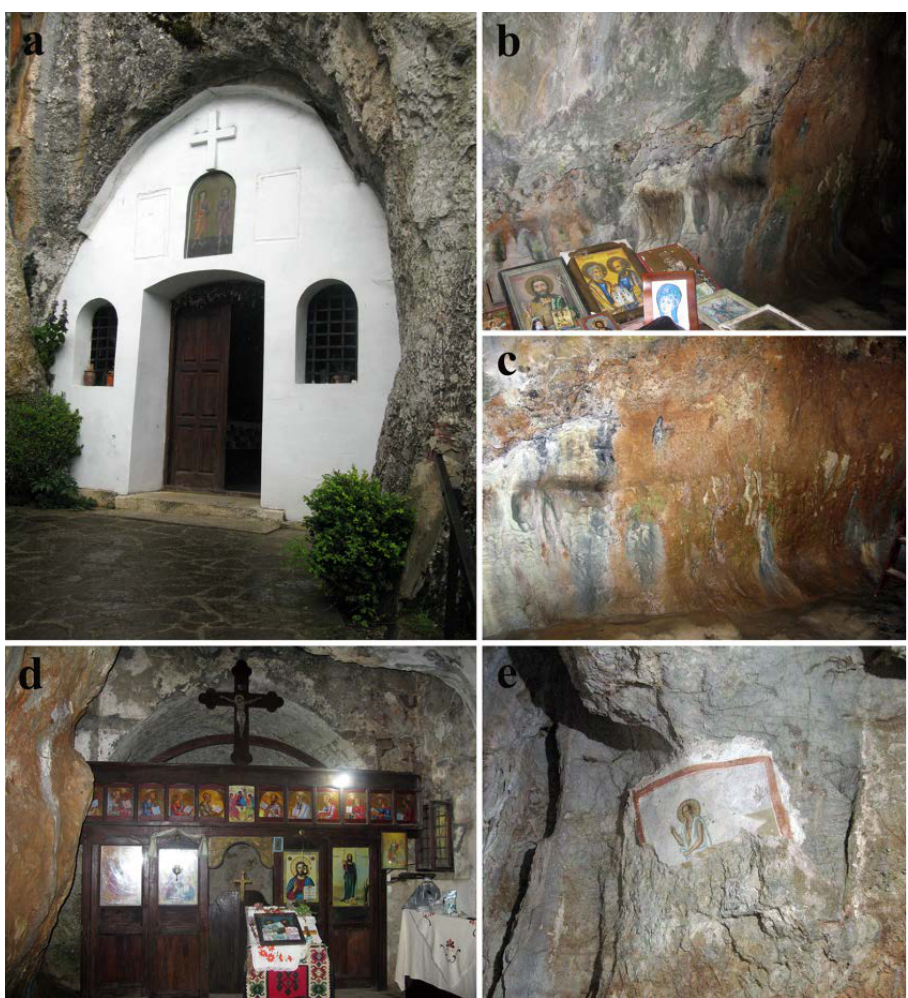
Figure 1. Cave Church of Sts. Peter and Paul: ( a ) exterior of the church; ( b,c ) southern cave walls; ( d ) wooden iconostasis; ( e ) fresco painting with a depiction of “The Bald-headed Jesus” on the northern wall.